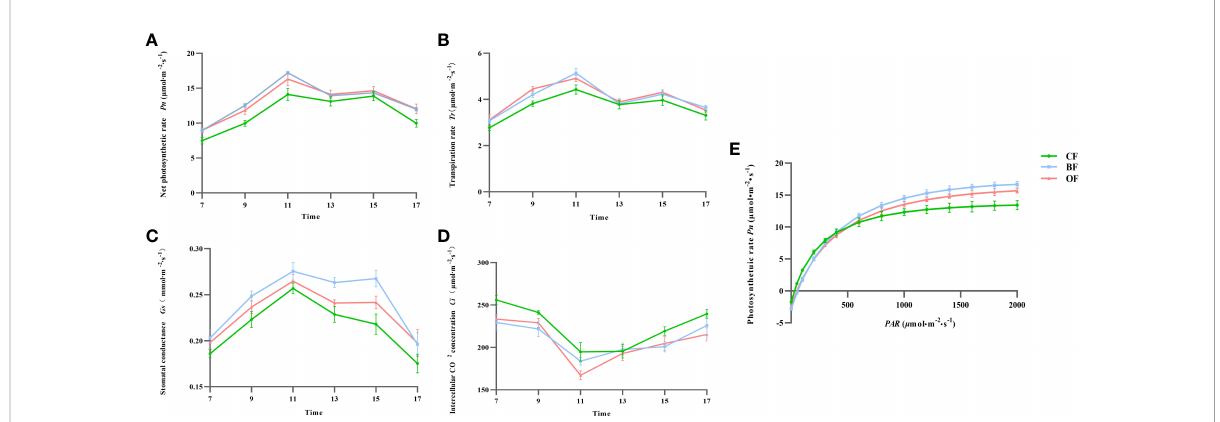
FIGURE 3 Fitting curves of T r (A) , P n (B) , G s (C) , C i (D) from 7 a.m. to 5 p.m and light response (E) from 9 a.m. to 12 a.m. in pear leaves with different fertilization treatments. CF, OF and BF denote for chemical fertilizer, organic fertilizer and bio-organic fertilizer, respectively. Pn , photosynthetic rate; Tr , transpiration rate; Ci , intercellular CO 2 concentration; Gs , stomatal